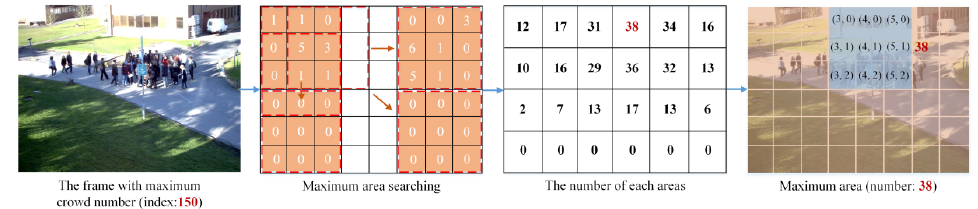
Figure 3. GAD for finding the gathering area.